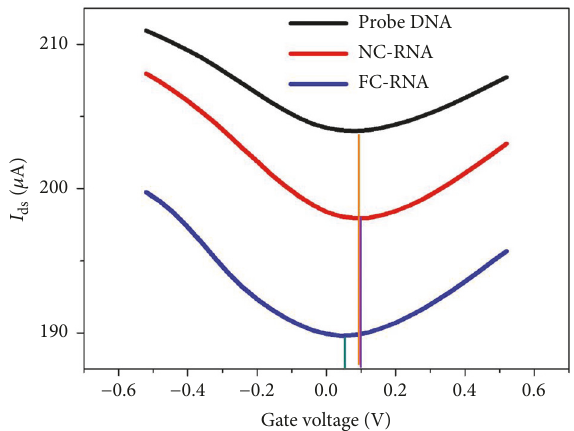
Figure 5: The transfer characteristics of the pristine DNA-modified G-FET biosensor (black) and after addition of NC-RNA (red) and FC-RNA (blue).